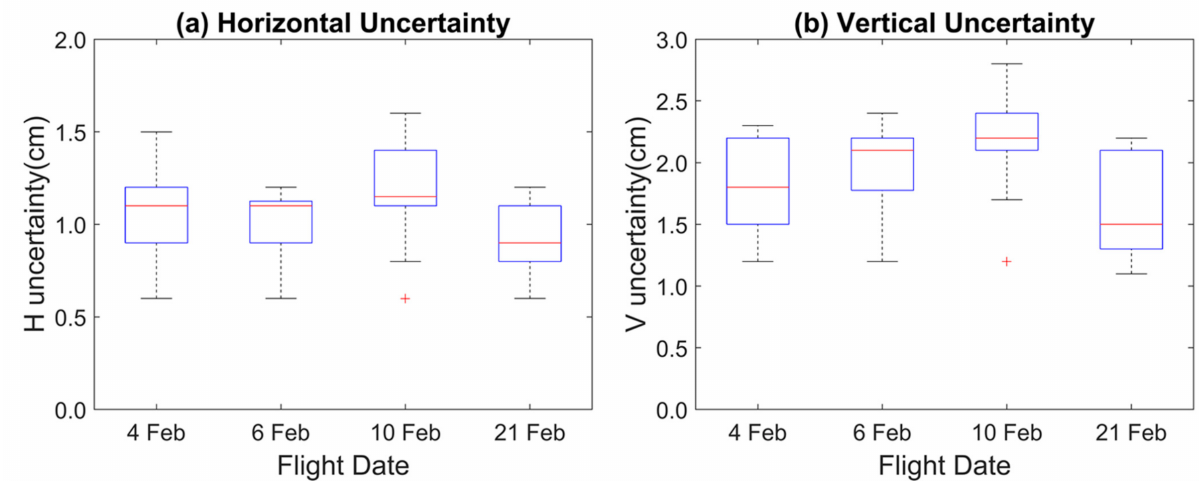
Figure 4. Box plot of ( a ) horizontal and ( b ) vertical uncertainties of 17 GCP measurements. Uncertainties of GCP on the snowed surface (4, 6, and 10 February) and on the original ground surface (21 February) were tested.